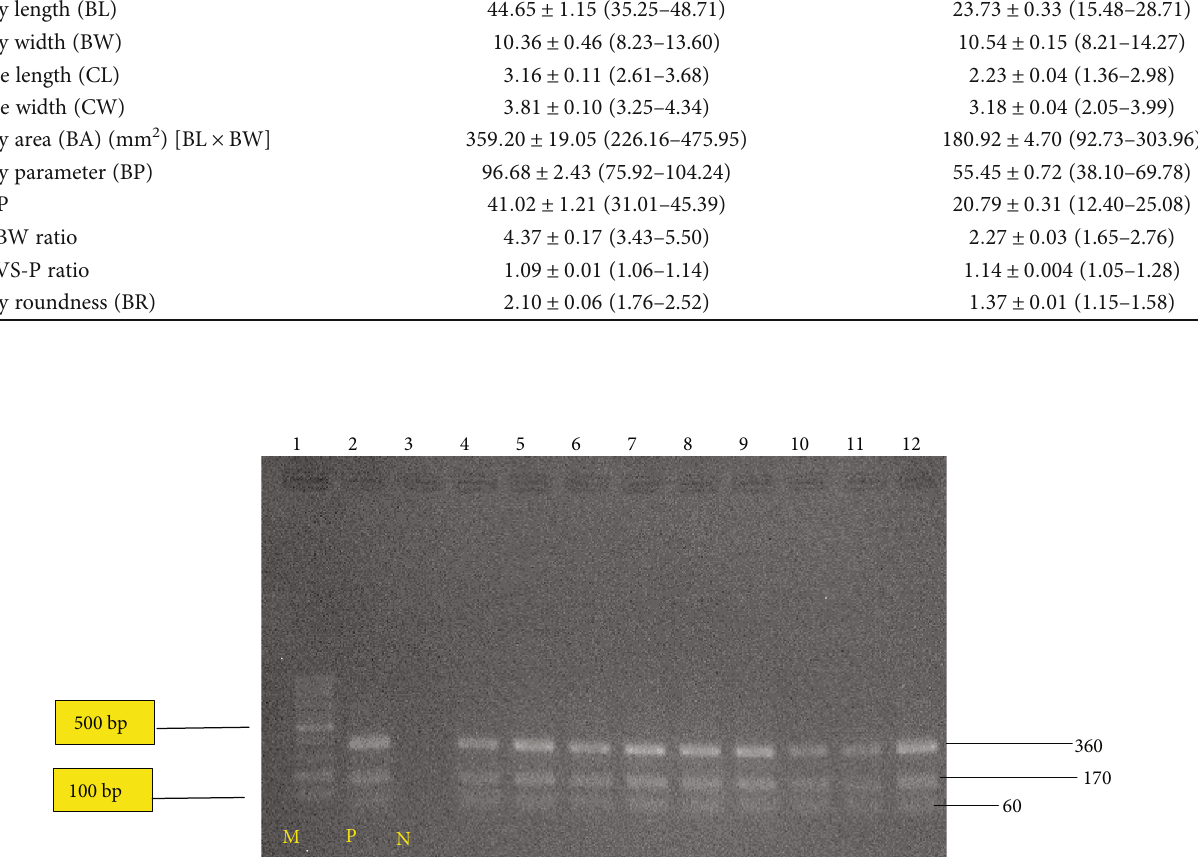
Fluke F. gigantica F. hepatica